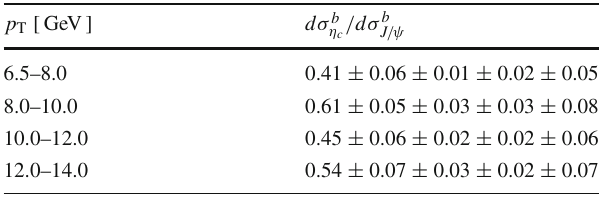
Table 7 Relative p T -differential η c production cross-section in inclu- sive b -hadron decays